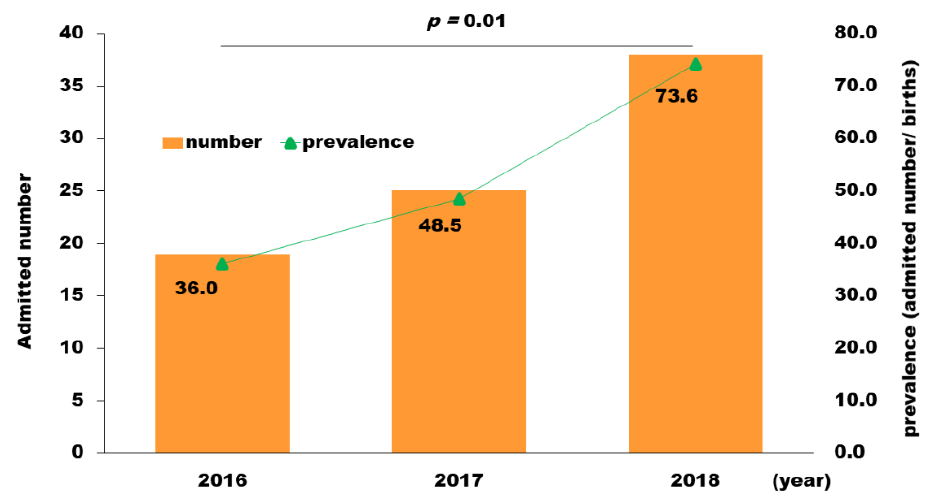
Figure 2. The annual number and prevalence of women admitted to mental health care units during the perinatal period. The number of admissions in 2018 (73.6 per 100,000 births) was approximately twice that in 2016 (36.0 per 100,000 births) ( p =0.01).